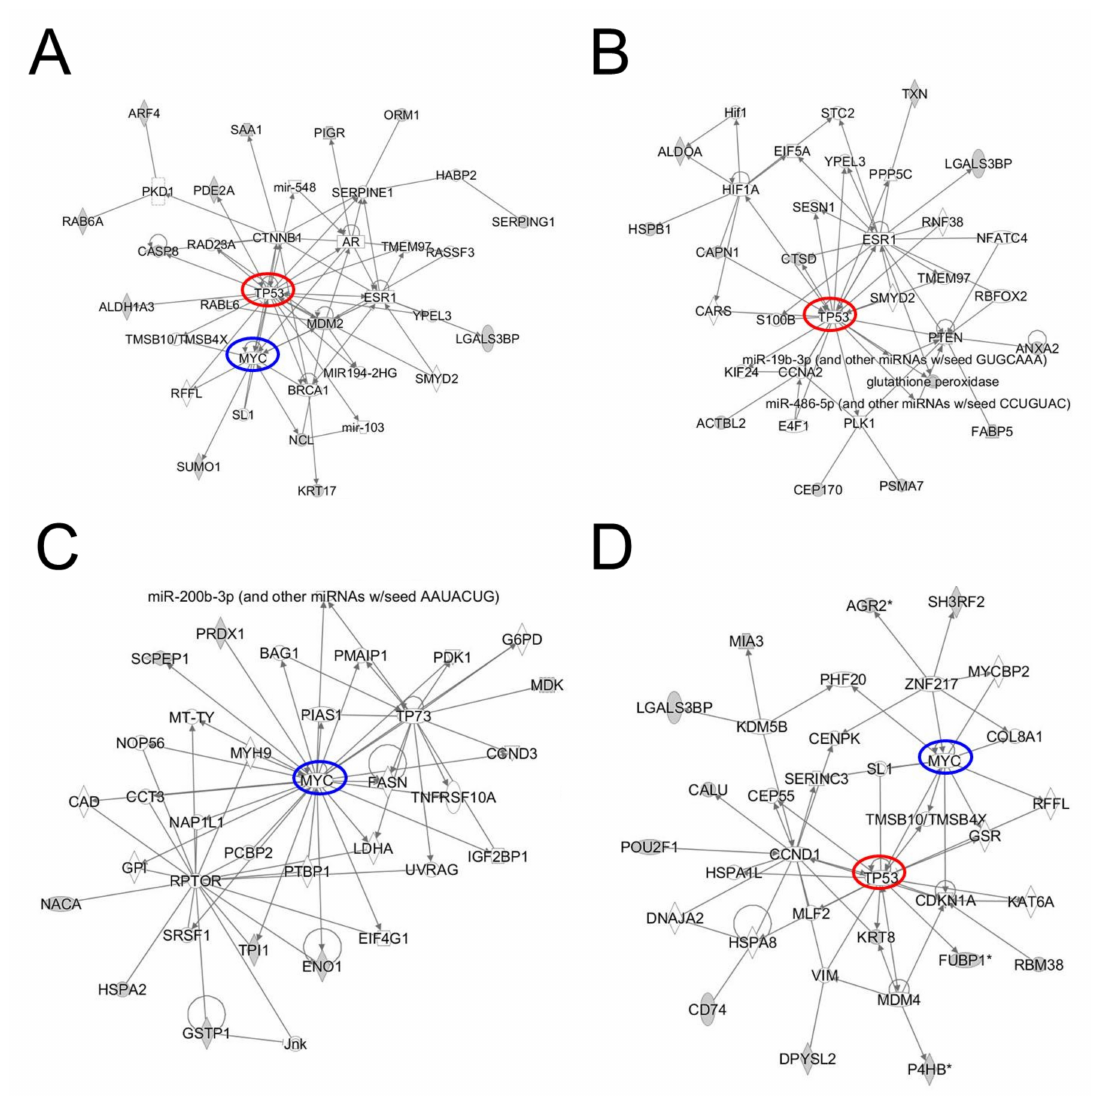
Figure 2. Autoimmune response signatures for ovarian cancer. Ingenuity Pathway Analysis (IPA) for immunoglobulin (Ig)-bound proteins that had a case–control ratio > 1.2 in early stage ovarian cancer and for which the protein target was identified ovarian cancer cell lines ( A ). ( B ) and ( C ) represent the top 2 IPA-derived networks based on Ig-bound protein features described in Table 3. ( D ) represents IPA-derived network based on OVCAR8 MHC-II bound peptidome. TP53 and MYC are marked as red and blue,